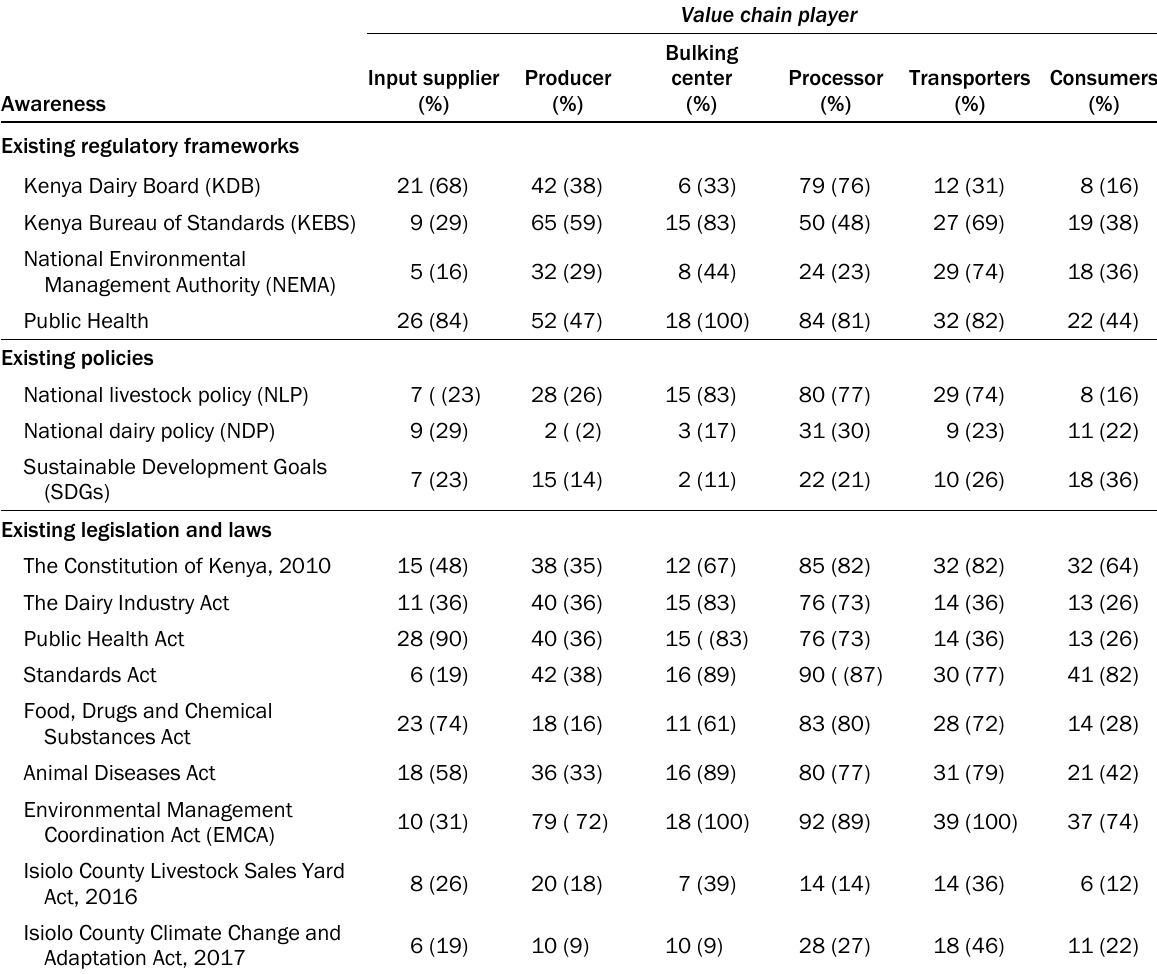
Table 4. Respondents’ Awareness of Various Legislation, Policies and Regulatory